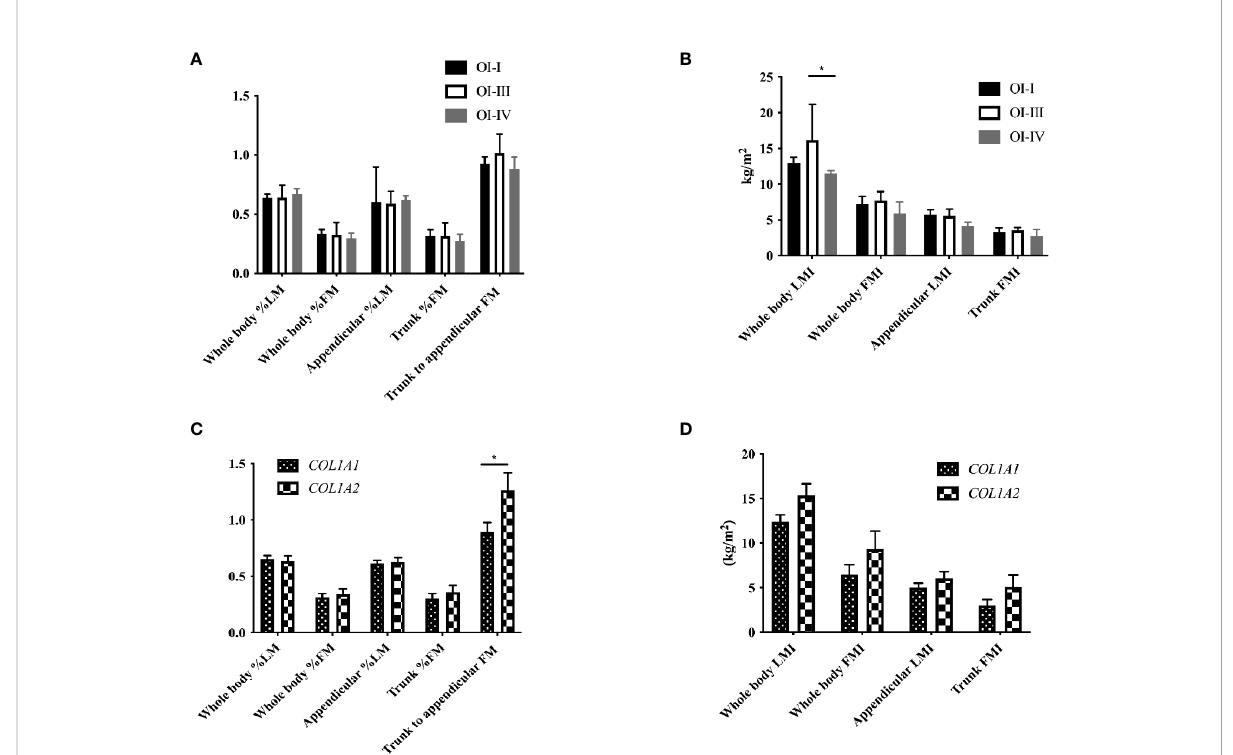
FIGURE 2 Body composition with different clinical and genotypic classi fi cations of OI children. (A) Body composition percentage in OI patients with different clinical classi fi cations. (B) Body composition index in OI patients with different clinical classi fi cations. (C) Body composition percentage in OI patients with COL1A1 and COL1A2 mutation. (D) Body composition index in OI patients with COL1A1 and COL1A2 mutation. *P < 0.05 for comparison between OI patients with COL1A1 and COL1A2 mutation.